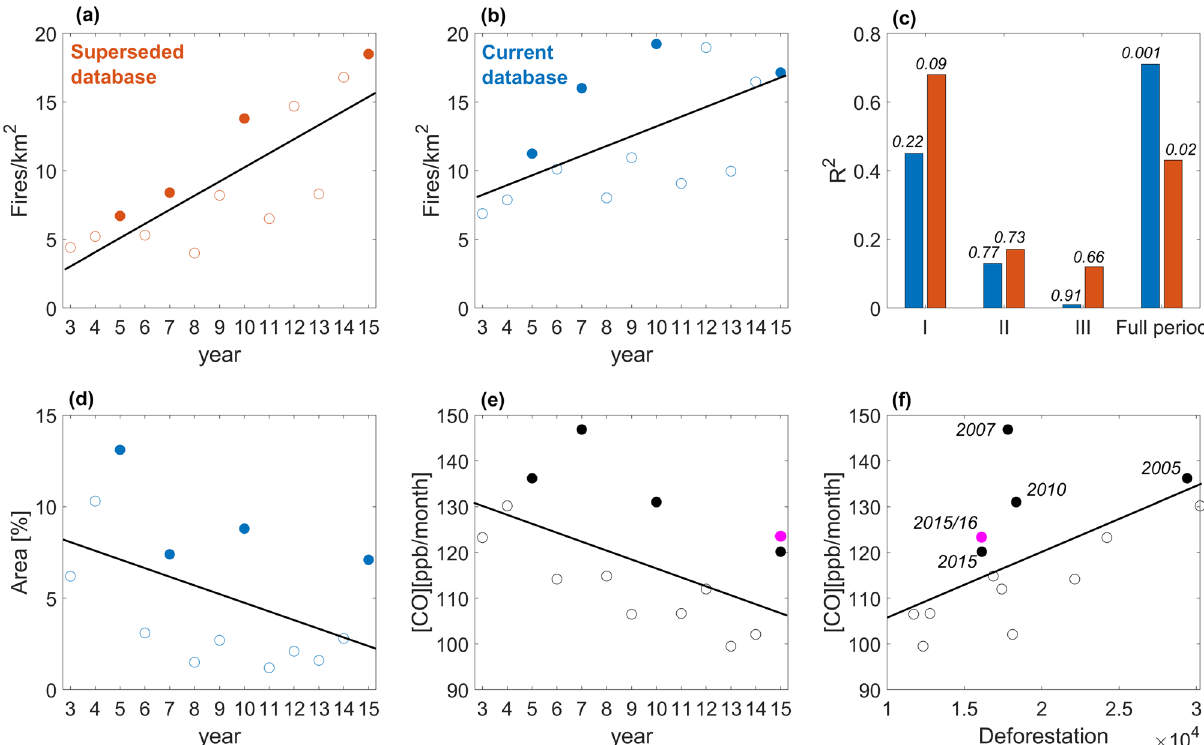
Figure 2. Time series of the annual number of active fires per km 2 deforested from ( a ) the superseded database (R 2 = 0.63; p value = 0.001) and ( b ) the current database (R 2 = 0.35; p value = 0.03). ( c ) R 2 for fire-deforestation regressions and respective p values (on top of bars) for the full period (2003–2015) and as in A2018 for the three PPCDAm (Phase I: 2004–2008, Phase II: 2009–2011, Phase III: 2012–2015). ( d ) Percent area of the BAMZ with active fire count anomalies in excess of 2 standard deviations using the current database. ( e ) Time series of the annual mean of monthly [CO] at 800 hPa (R 2 = 0.32; p value = 0.043). ( f ) Regression of mean monthly [CO] at 800 hPa on annual deforestation rates from the Global Forest Change (GFC) product 38 (R 2 = 0.27; p value = 0.07). Full dots in panels ( a ), ( b ), ( d ), ( e ), and ( f ) indicate drought years (2005, 2007, 2010 and 2015). The magenta dot in panels ( e ) and ( f ) represents active fire counts (the current database) for April 2015 to March